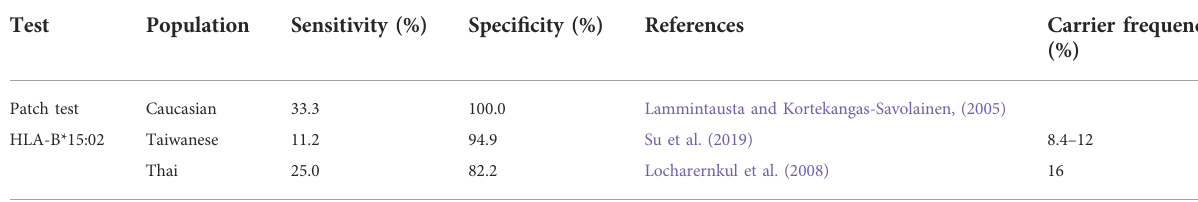
TABLE 7 Sensitivity and speci fi city of patch tests and HLA tests for phenytoin-induced MPE.